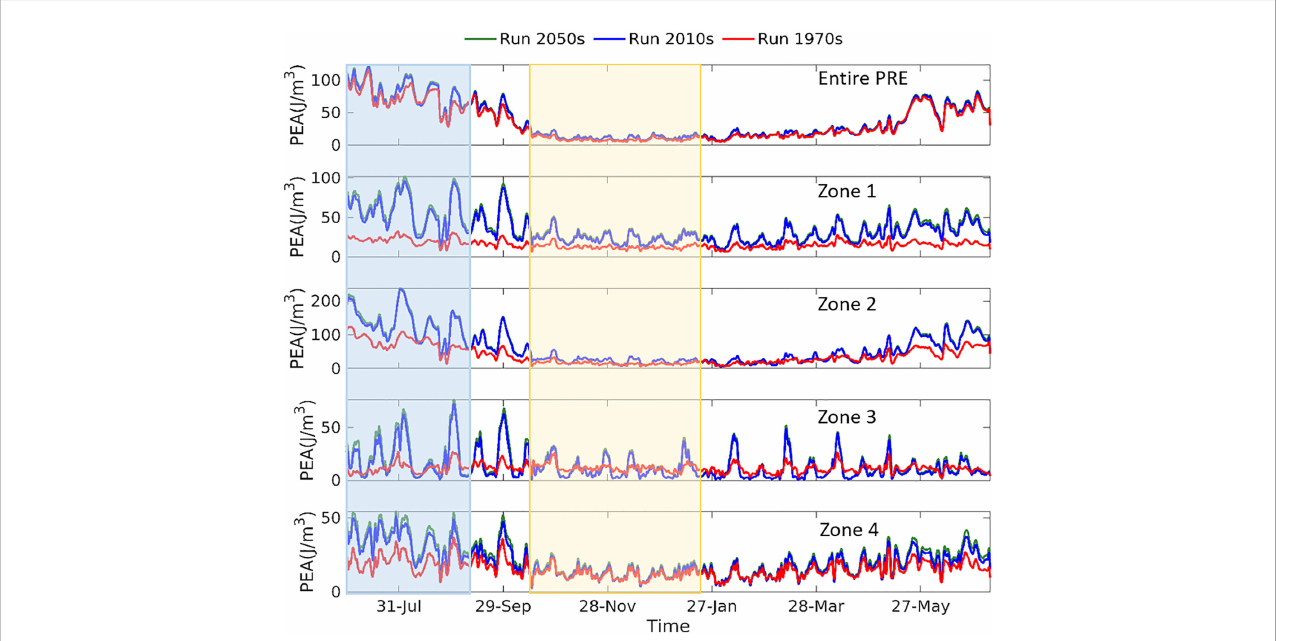
FIGURE 4 Time series of daily-averaged potential energy anomaly ( j ) in the entire PRE and different sub-regions in the three scenarios (Run_1970s, Run_2010s and Run_2050s). The light blue and yellow rectangles indicate the wet season (July and August) and dry season (October, November and December),